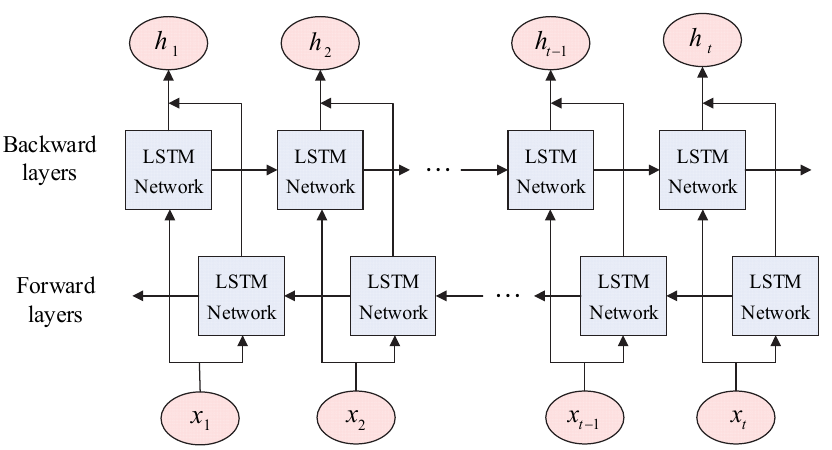
Figure 7. Bidirectional long short-term memory neural network.